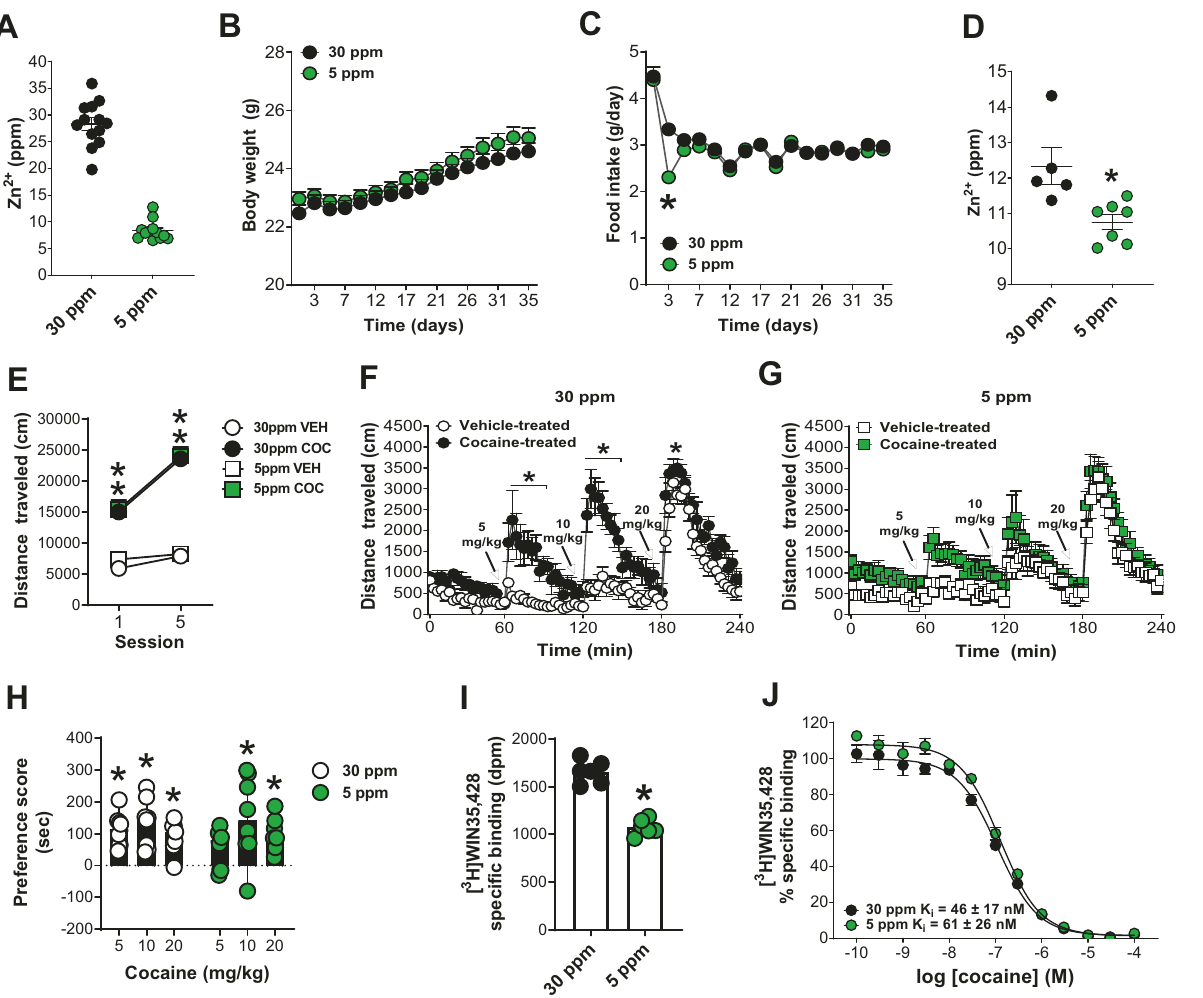
Fig. 5 Dietary Zn 2 + de fi ciency decreases brain Zn 2 + and attenuates cocaine locomotor sensitization, reward, and striatal DAT binding. A Total re fl ection X-ray spectroscopy (TXRF)-based veri fi cation of Zn 2 + content in custom-made diets. B Mice fed a 5 ppm Zn 2 + diet did not differ in body weight from mice fed a 30 ppm Zn 2 + diet. C Mice fed a 5 ppm Zn 2 + diet showed a signi fi cant decrease in food intake 3 days after diet initiation compared to mice fed a 30 ppm diet but did not differ at other times. D Mice fed a 5 ppm Zn 2 + diet showed signi fi cantly lower total Zn 2 + in frontal/cingulate cortex compared to mice fed a 30 pm Zn 2 + diet. E Mice fed 5 ppm or 30 ppm Zn 2 + diets did not differ in development of cocaine (COC) locomotor sensitization (VEH- vehicle). F Cocaine-treated 30 ppm diet mice ( n = 6) showed signi fi cantly greater expression of cocaine locomotor sensitization at 5, 10 mg/kg and 20 mg/kg cocaine compared to vehicle-treated 30 ppm mice ( n = 13). G Cocaine-treated 5 ppm mice did not show any signi fi cant difference in expression of locomotor sensitization compared to vehicle-treated 5 ppm mice. H Mice fed a 30 ppm Zn 2 + diet showed signi fi cant preference for a chamber paired with cocaine at 5, 10, and 20 mg/kg. Mice fed a 5 ppm Zn 2 + diet showed signi fi cant preference for a chamber paired with cocaine at 10, and 20 mg/kg but not at 5 mg/kg. I Mice exposed to cocaine and a 5 ppm Zn 2 + diet showed signi fi cantly lower DAT binding in striatum and J a mild decrease in cocaine af fi nity compared to mice exposed to cocaine and a 30 ppm diet. dpm - disintegrations per minute. * p ≤ 0.05. All data except panel H expressed as Mean ± SEM. Panel H is expressed as Median ± 95% per group, in triplicate) and a decrease in cocaine af fi nity compared to mice exposed to cocaine and a 30 ppm Zn 2 + diet ( n = 6) (5 ppm K i = 61 ± 26 nM; 30 ppm Ki = 46 ± 17 nM) (3 repetitions per curve, in triplicate) (Fig. 5J).